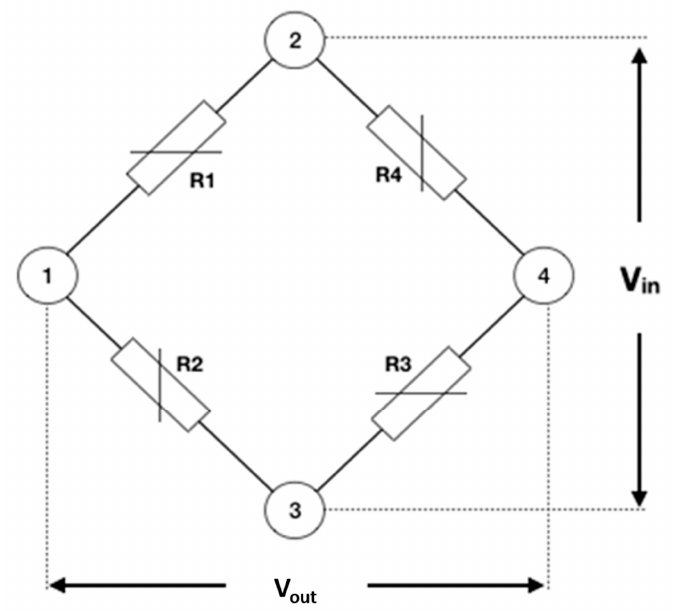
Figure 8. Wheatstone electrical circuit ( 1